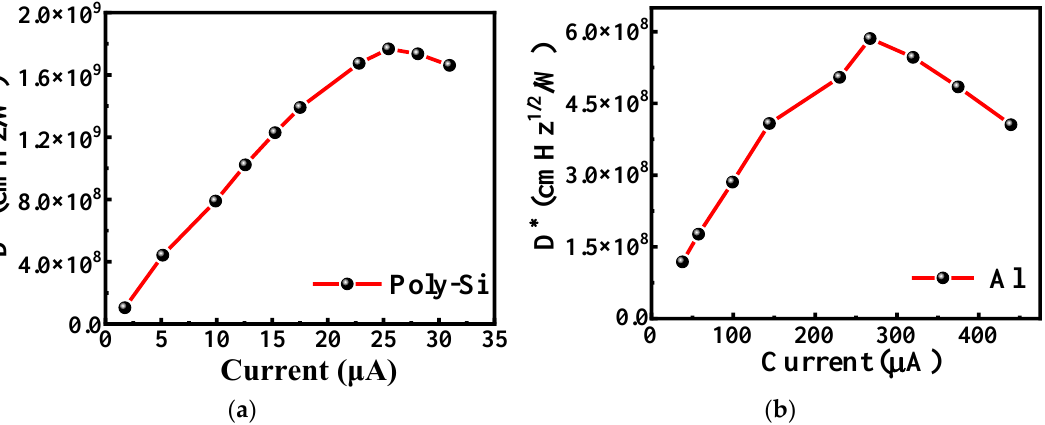
Figure 8. Evaluated detectivity of ( a ) the salicide polysilicon microbolometer and ( b ) metal Al microbolometer under various bias currents.